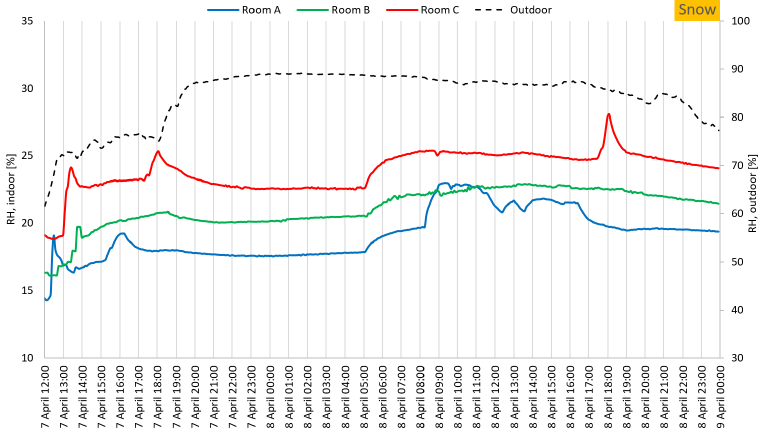
Figure 19. Comparison of RH outdoors and indoors in all three rooms for 1.5 days when it was snowing outside. The indoor RH of the three rooms is shown on the left axis, and the outdoor RH is shown on the right axis.